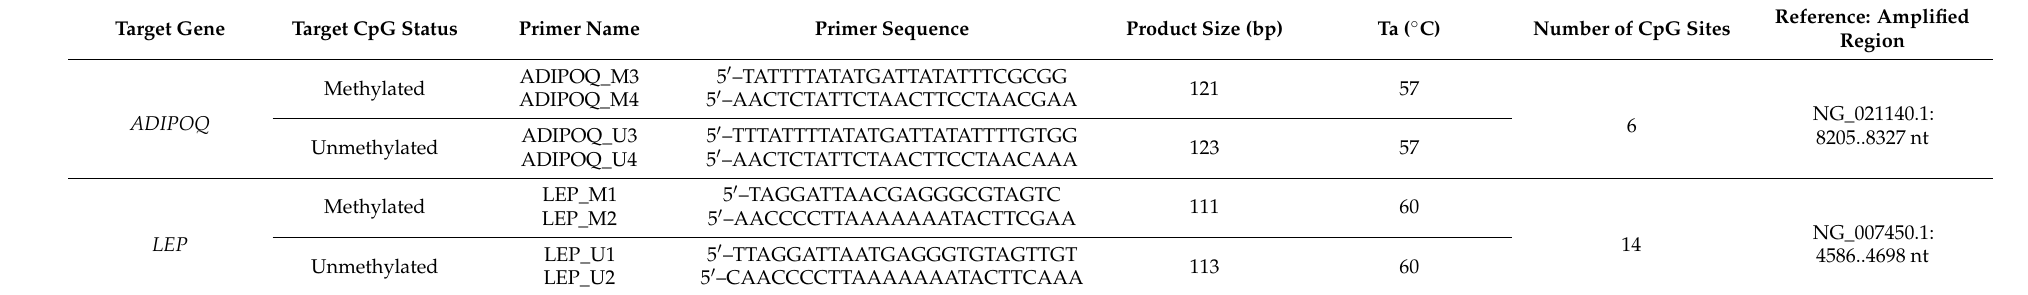
Table 3. Primers used in the methylation-specific real-time qPCR assay. Primer sequences were designed specifically using methylated and unmethylated templates after bisulfite modification. The size of the PCR product, annealing temperature (T a ) for primer pairs, the number of CpG sites that are within the PCR product, reference sequence, and location of the amplified region are